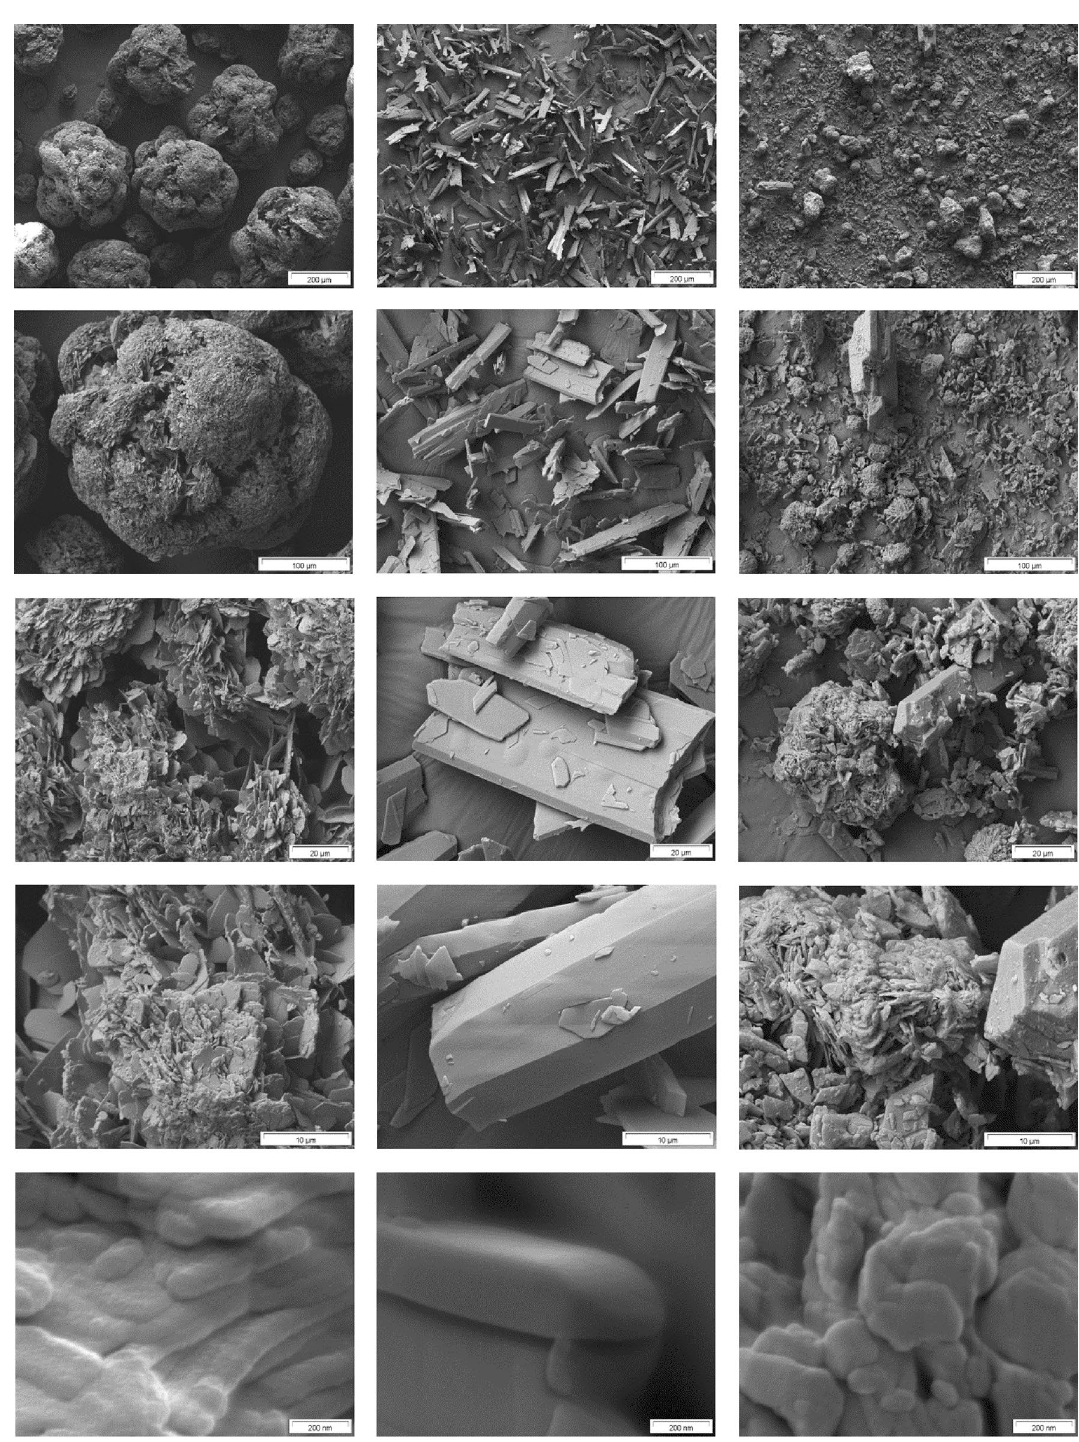
Figure 2. SEM images with increasing magnification of the samples “as received”, dusted onto adhesive carbon tape, show the morphology from the macroscale down to submicron dimensions. From left to right dl–ld isolated/separated dl–ld fraction; dd–ll isolated/separated dd–ll fraction; mixture (37% dd/ll + 63% dl/ld). From top to bottom the scale bars are: 200, 100, 20, 10 μm and 200